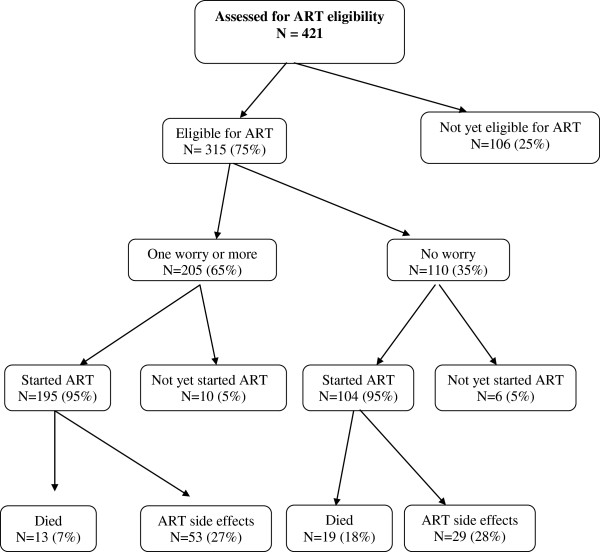
Flow chart of study participants.